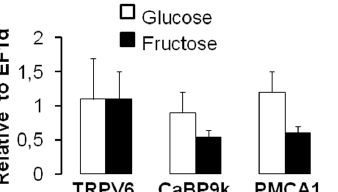
Figure 6. Effect of chronic fructose feeding on Ca 2 + transporter expression in rat intestine. Rats were fed for three mo a normal Ca 2 + diet containing either 43% glucose or fructose. mRNA expression levels of intestinal Ca 2 + (TRPV6, CaBP9k, PMCA1) transporters remained similar between diets.